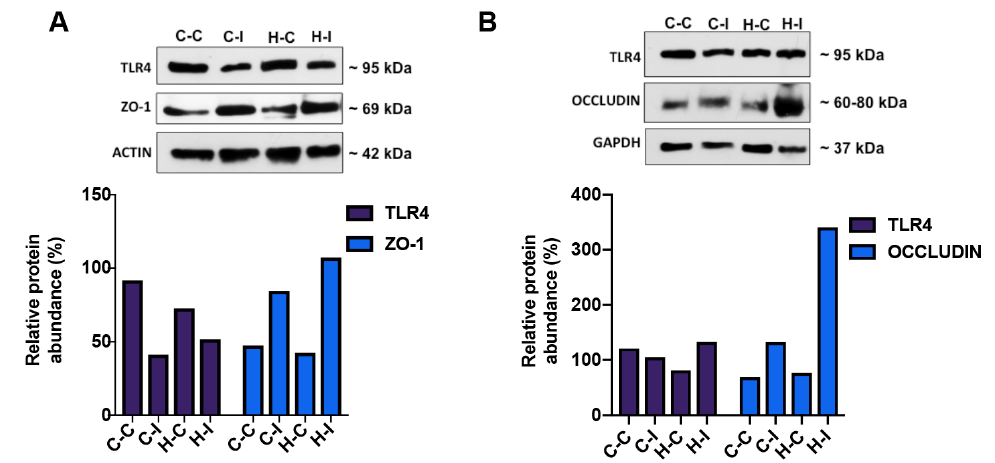
Figure 6. Inulin supplementation promotes the expression of tight junction proteins in the liver ( A ) or gut ( B ). Tissue representative blots from each mice group for toll-like receptor 4, ZO-1 and occludin proteins. Plots below indicate quantitation of the corresponding protein in fold percentage change.